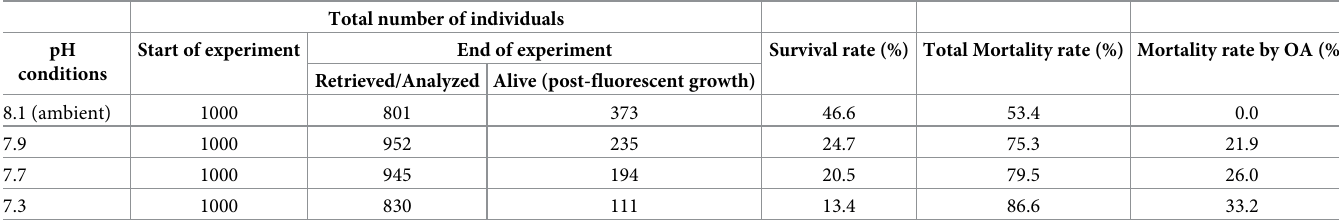
Table 1. Number of individuals of Elphidium williamsoni cultured under different pH conditions (pH 8.1 (ambient), pH 7.9, pH 7.7 and pH 7.3).